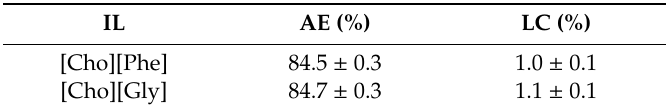
Table 2. Association e ffi ciency (AE) and loading capacity (LC) of rutin-loaded ILs-PLGA nanoparticles hybrid systems. Data represented as mean ± SD ( n = 3).